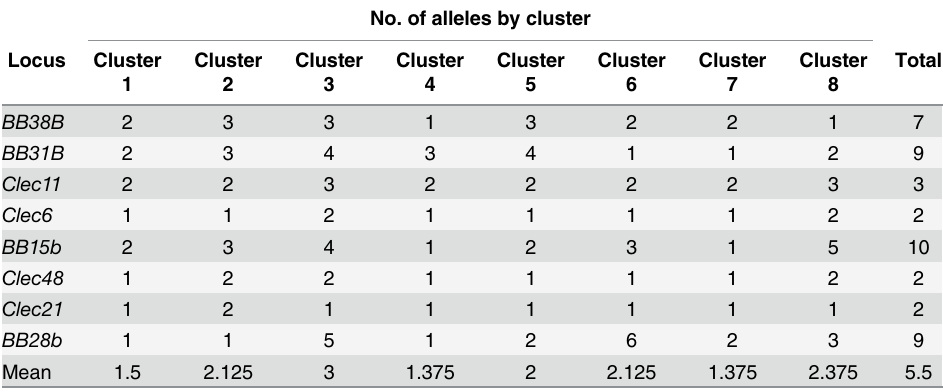
The total number of alleles is given for all samples combined and for the samples from the apartment complex separately.